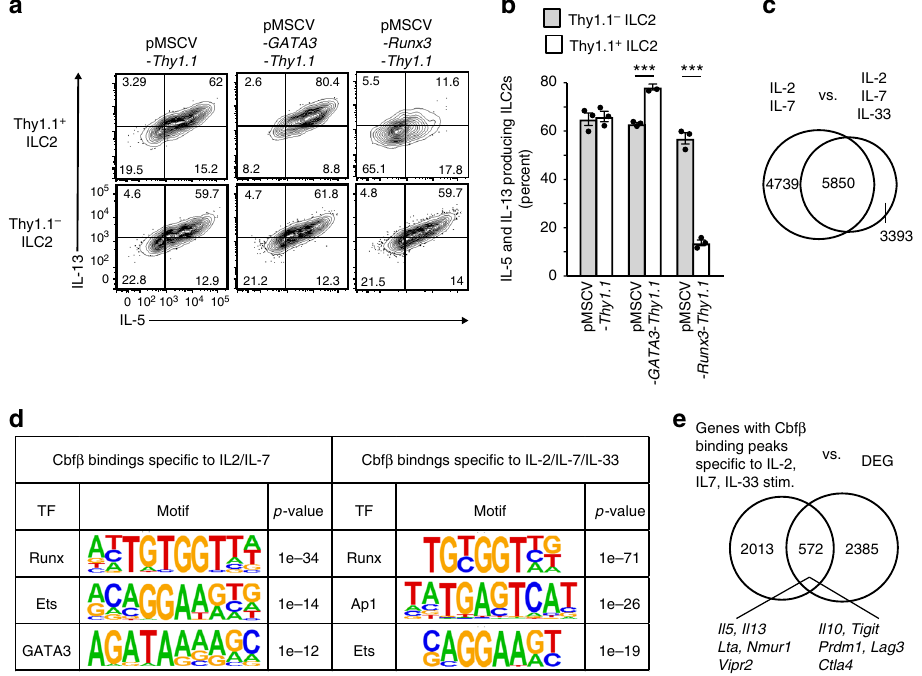
Fig. 5 Differential functions of the GATA-3 and Runx proteins in activated ILC2s. a Flow cytometry analysis of IL-5 and IL-13 production by ILC2s transfected with the indicated retroviral vectors and cultured with IL-2, IL-7, and IL-33. Thy1.1 is a surrogate marker for transduction. b The frequency of cells producing both IL-5 and IL-13 in the indicated ILC2s was determined by fl ow cytometry as in a . c Venn diagram showing the number of binding events in ILC2s cultured with IL-2/IL-7 or IL-2/IL-7/IL-33 in vitro. d Motif analysis of Cbf β binding peaks speci fi c to the indicated ILC2s. e Venn diagram showing the number of genes with Cbf β binding peaks speci fi c to ILC2s cultured with IL2/IL-7/IL33 in vitro and differentially expressed genes (DEG) in Cbfb f/f PLZF- Cre ILC2s compared to Cbfb + /f PLZF-Cre ILC2s. The numbers indicate the percentages of cells in each quadrant ( a ). In b , *** p < 0.001 by Student ’ s t -test. Data are representative of at least two independent experiments (mean ± s.d. of three mice in b ) NATURE COMMUNICATIONS| (2019) 10:447